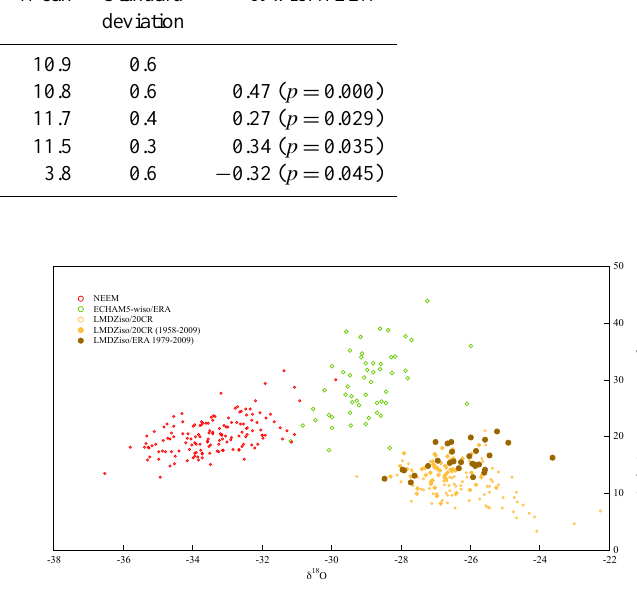
Figure 9. Relationship between accumulation or precipitation (cm water equivalent per year) and δ 18 O (‰) in NEEM ice core stack (red) and in different simulations